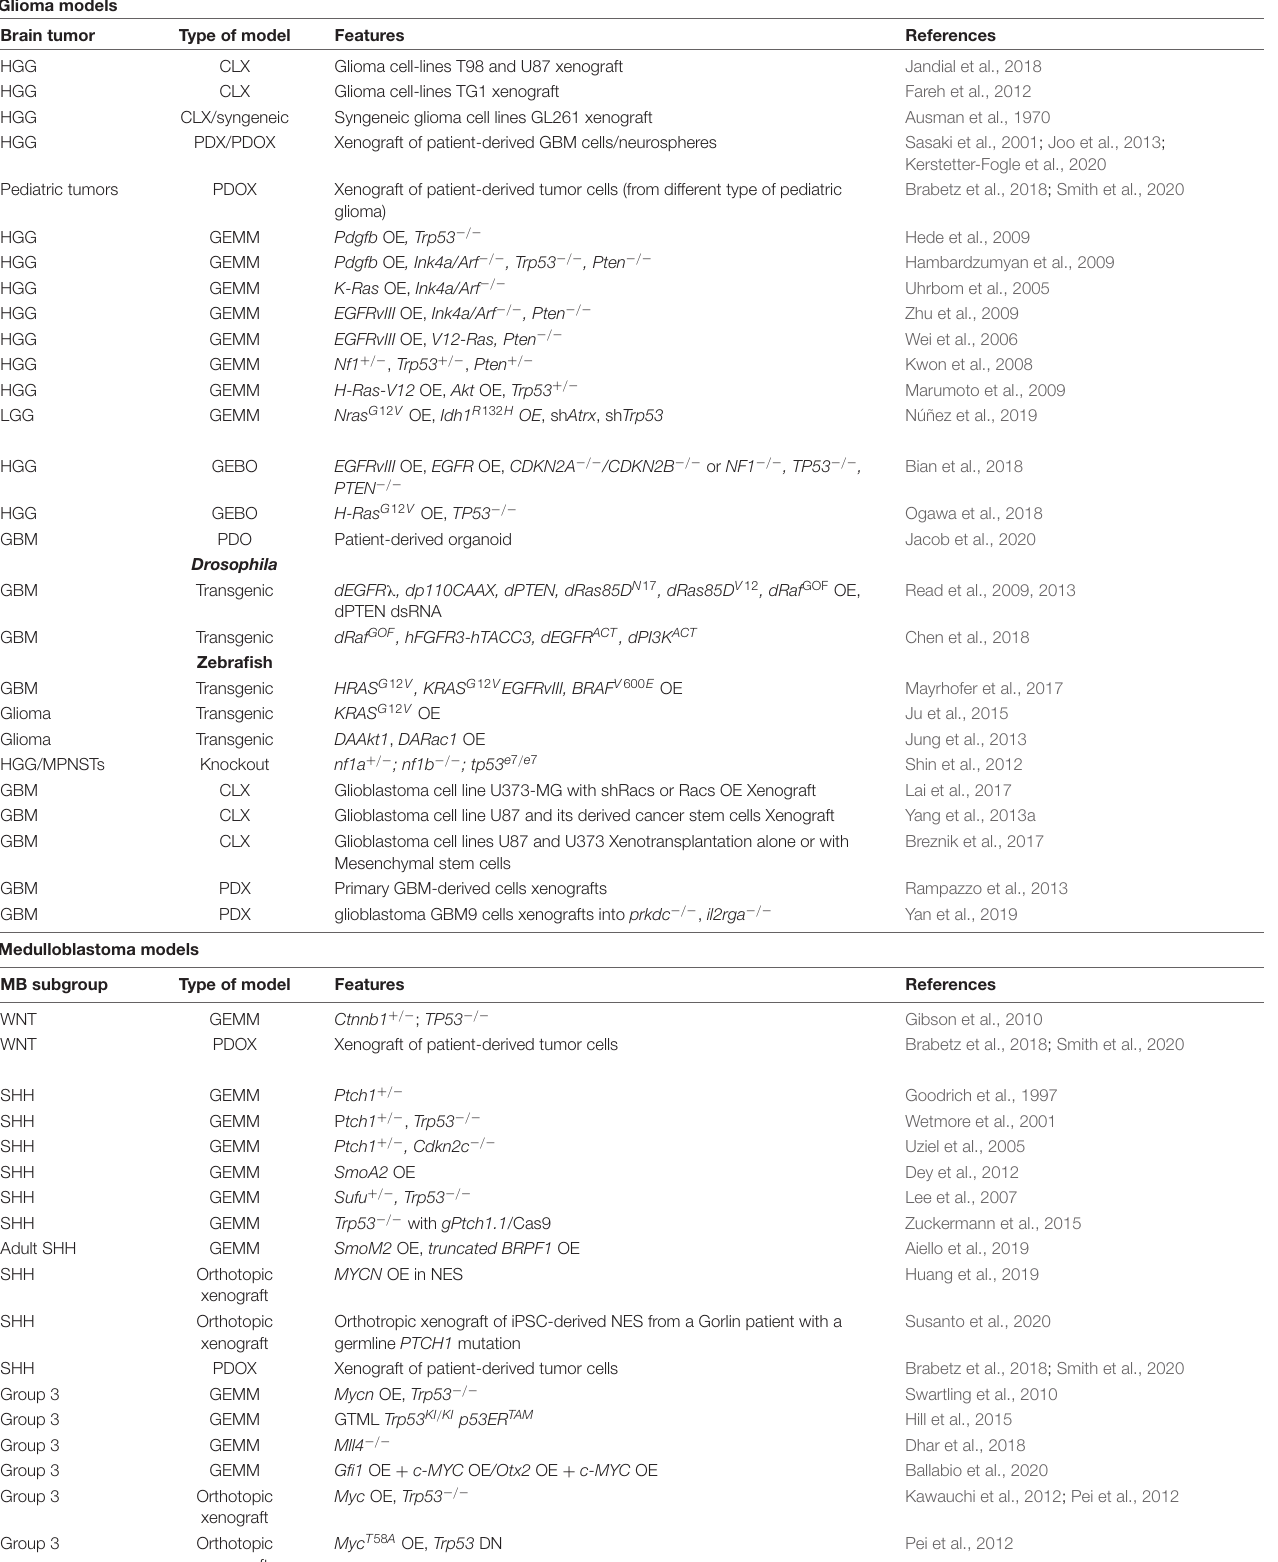
TABLE 1 | An example of different types of brain tumor models and their relative